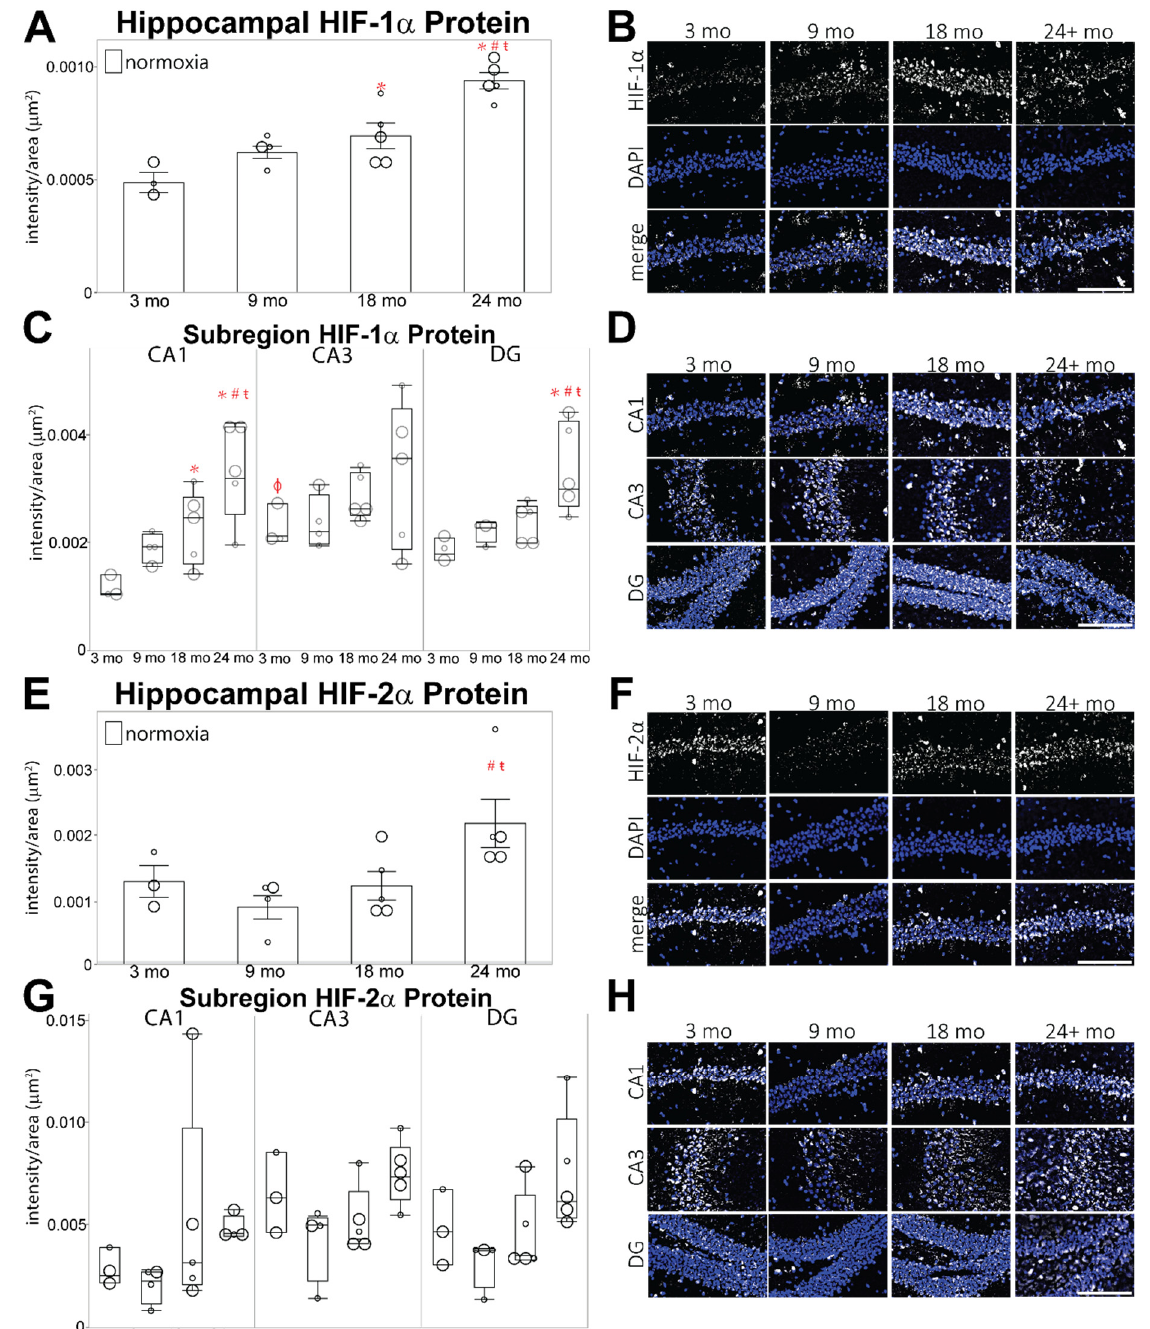
Figure 3. Hippocampal HIF- α protein levels are elevated with age. ( A , E ) HIF-1 α ( A ) and HIF-2 α ( E ) protein reported as intensity/ μ m 2 using IHC on hippocampal slices from 3 mo, 9 mo, 18 mo, and 24 mo age groups. ( B , F ) Representative images of HIF-1 α ( B ) and HIF-2 α ( F ) intensity IHC observations. White spots are HIF-1 α , and blue spots are DAPI. ( C , G ) HIF-1 α ( C ) and HIF-2 α ( G ) protein measured as intensity/ μ m 2 within hippocampal subregions (dentate gyrus [DG], CA1, and CA3) of different aged mice. ( D , H ) Representative images of HIF-1 α ( D ) and HIF-2 α ( H ) intensity within each subregion. Images are displayed as merged channels with HIF-1 α or HIF-2 α in white and DAPI in blue. Scale bar = 150 μ m; p ≤ 0.05; * = compared to 3 mo normoxic control; # = compared to 9 mo; ŧ = compared to 18 mo; ϕ = compared to other age-matched regions; small dots = female mice; large dots = male mice.